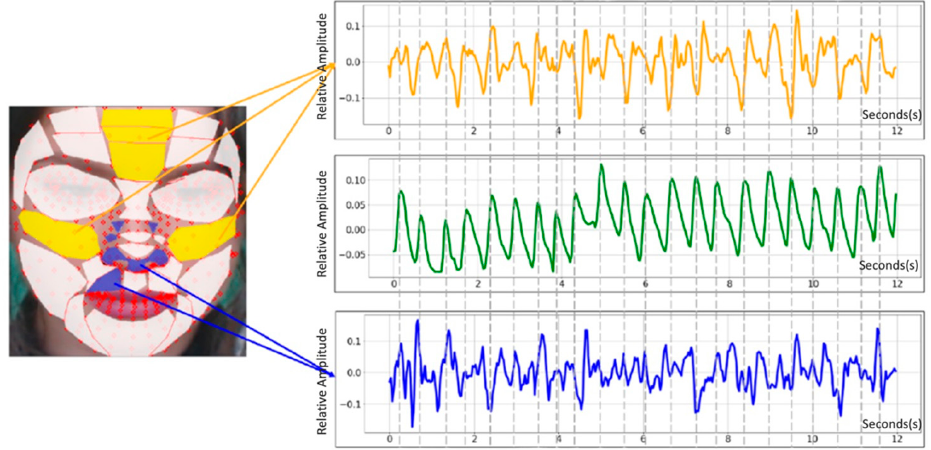
Figure 4. PPG extraction accuracy evaluation according to face area. (Top-5: yellow, Bot-5: blue).